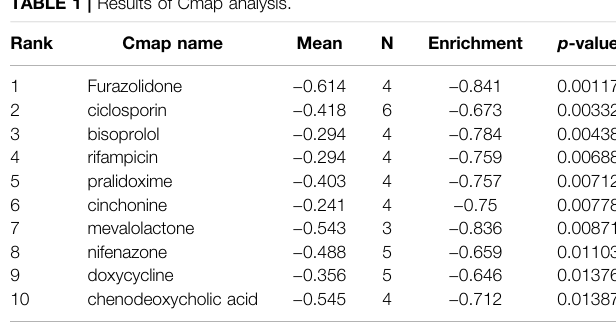
TABLE 1 | Results of Cmap